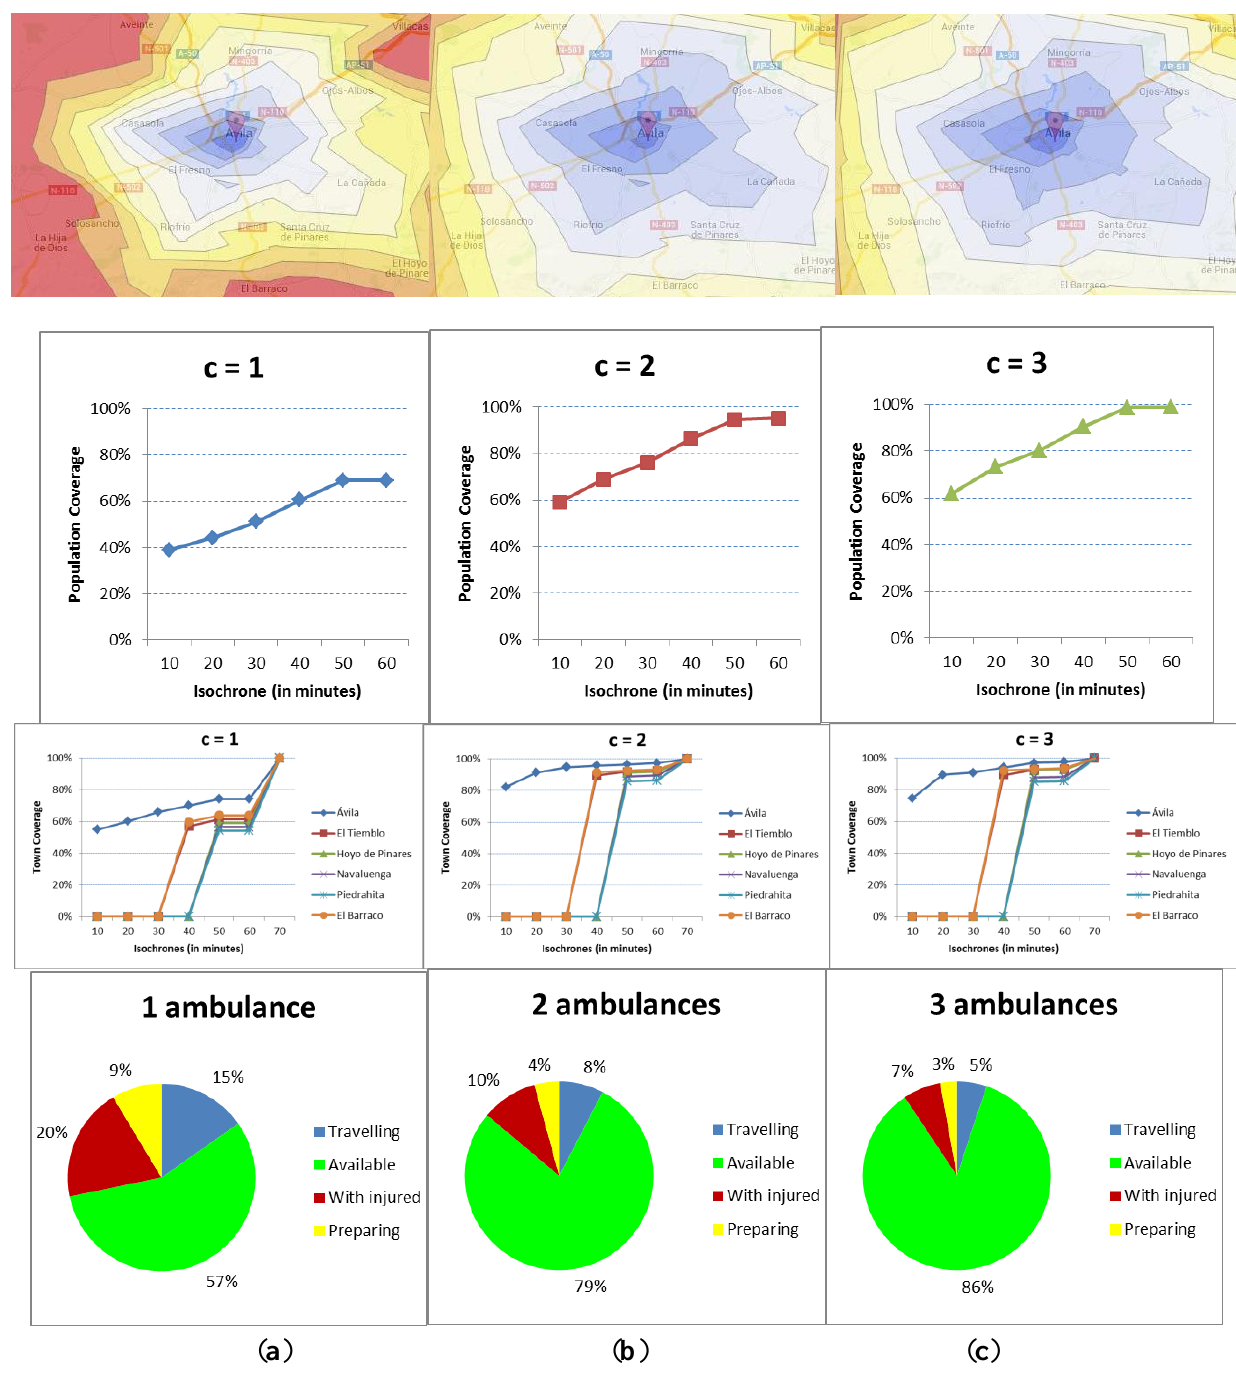
Figure 10. ( a ) Results for one ambulance; ( b ) Results for two ambulances; ( c ) Results for three